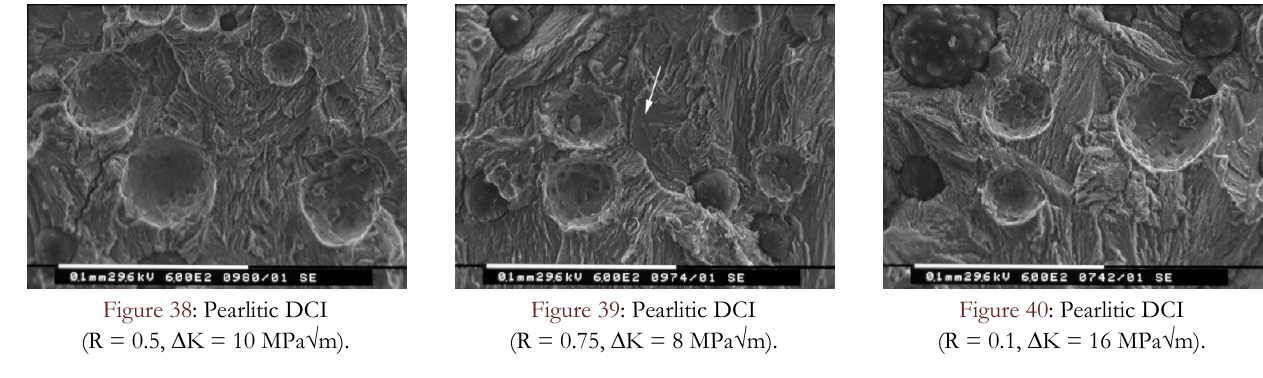
Figure 38: Pearlitic DCI (R = 0.5,  K = 10 MPa √ m).